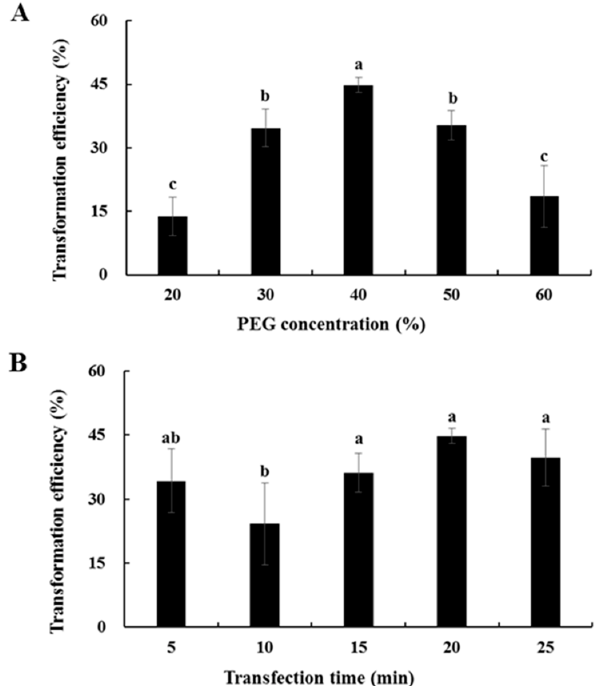
Figure 7. Effects of PEG4000 concentration and transformation time on protoplast transformation efficiency: ( A ) PEG4000 concentration; ( B ) Transformation time.